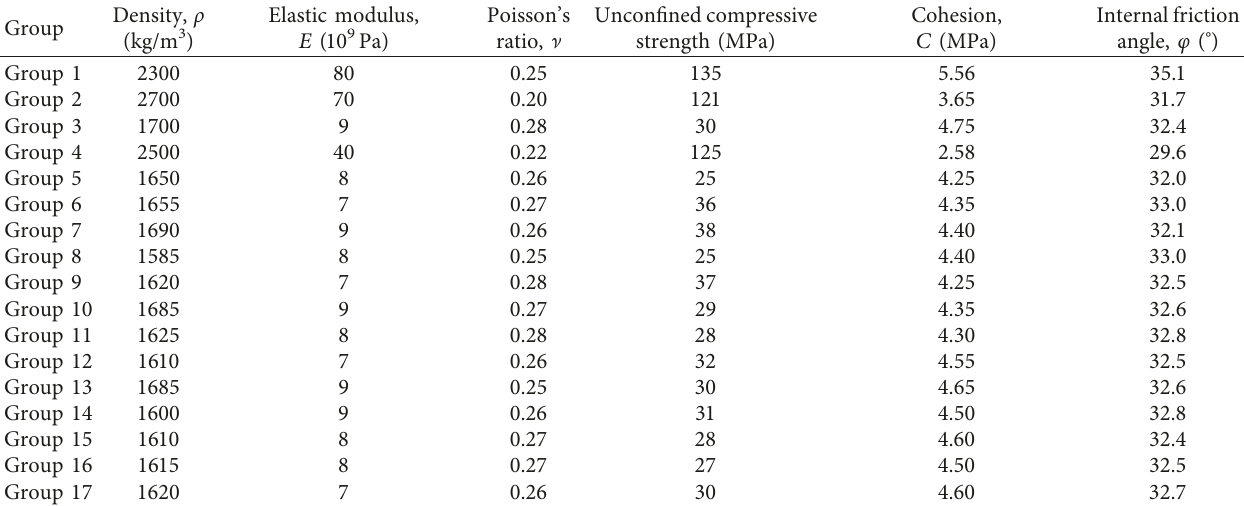
Table 1: Material parameters of the numerical